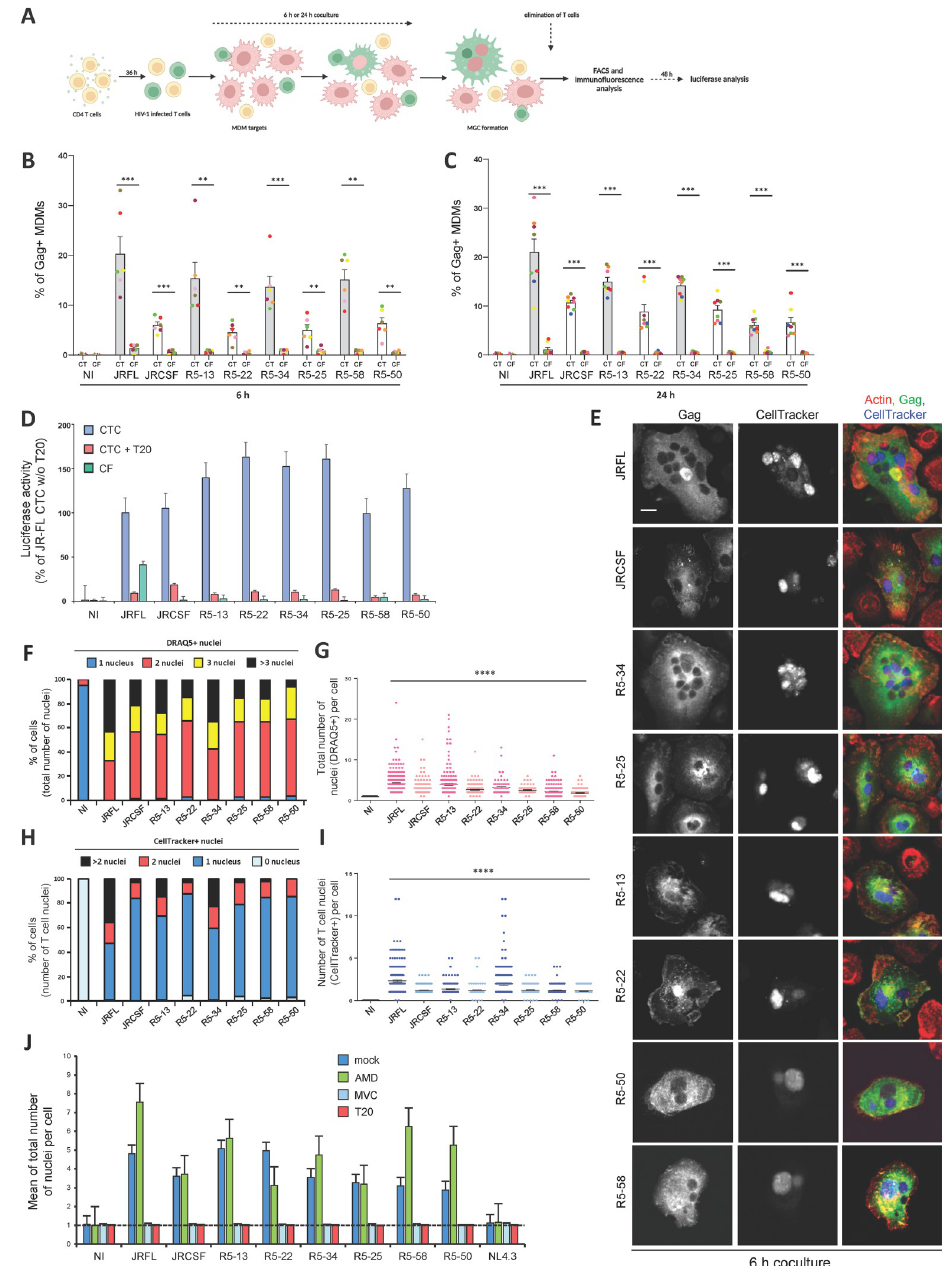
Fig 2. Cell-to-cell transfer to macrophages of R5 M- and non-M-tropic HIV-1 through cell-cell fusion with infected T cells. A) Experimental design for HIV-1 cell-to-cell transfer from infected CD4+ T cells to MDMs. B, C) MDMs were exposed to cell-free (CF) virus-containing supernatants of Jurkat cells infected with viruses pseudotyped with the indicated CCR5-using Envs or cocultured (CT) with Jurkat cells infected with the corresponding M- (grey bars) or non-M-tropic (white bars) viruses. The percentage of Gag+ MDMs was then determined by flow cytometry 6 ( B ) or 24 ( C ) h later. The results show the percentage of Gag+ MDMs. Non-infected MDMs or MDMs cocultured with non-infected Jurkat cells were used as negative controls (NI) of cell-free or cell-to-cell infection, respectively. Each dot corresponds to MDMs from an individual donor. D) MDMs were infected by cell-free (green bars) or cell-to-cell viral transfer in the presence (red bars) or absence (blue bars) of T20 for 24 h. After elimination of the cell-free virus inoculum or infected Jurkat cells, MDMs were cultured for 48 more hours before quantification of the luciferase activity. The results are expressed as the percentage of the luciferase activity measured for the JRFL Env-pseudotyped viral clone. E-J) Jurkat cells infected with the indicated Env-pseudotyped virus clones and prelabeled with CellTracker were co-cultured for 6 ( E-I ) or 24 ( J ) h with MDMs. After elimination of Jurkat cells, MDMs were stained with